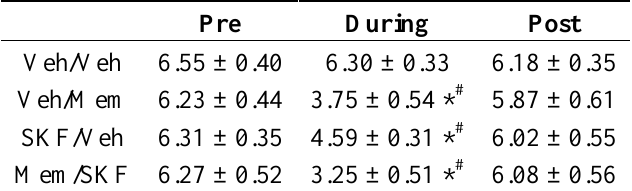
Table 3. Effects of 5.0 mg/kg SKF-38393, 10 mg/kg memantine, or in combination b.i.d. for three days on daily ethanol consumption, proportion of fluids consumed and food